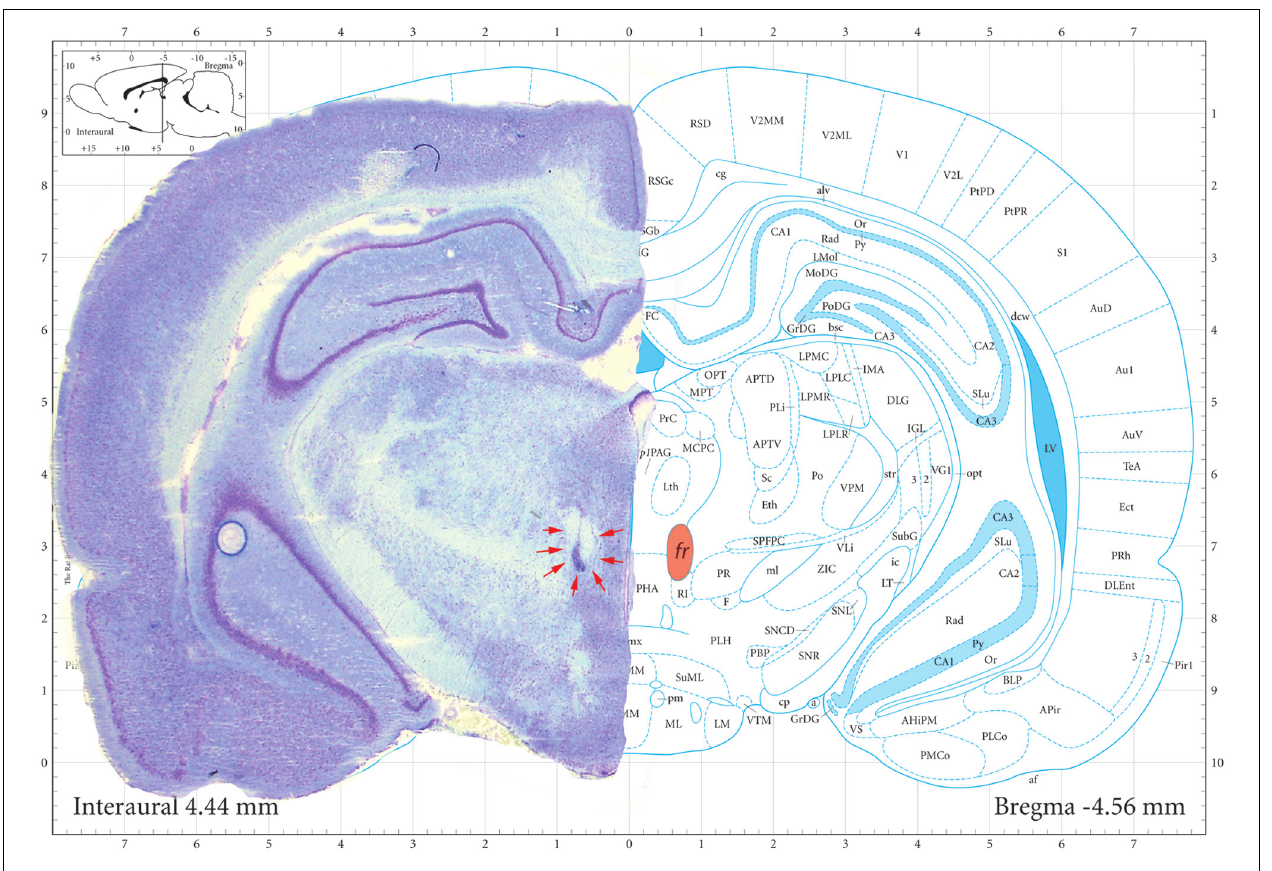
FIGURE 2 | Representative photomicrograph of an fr lesion. Photomicrograph of section stained with cresyl violet. Electrolytic fr lesions were made consecutively on each side of the brain. Orange shaded region on the right highlights fr location and the arrows on outline